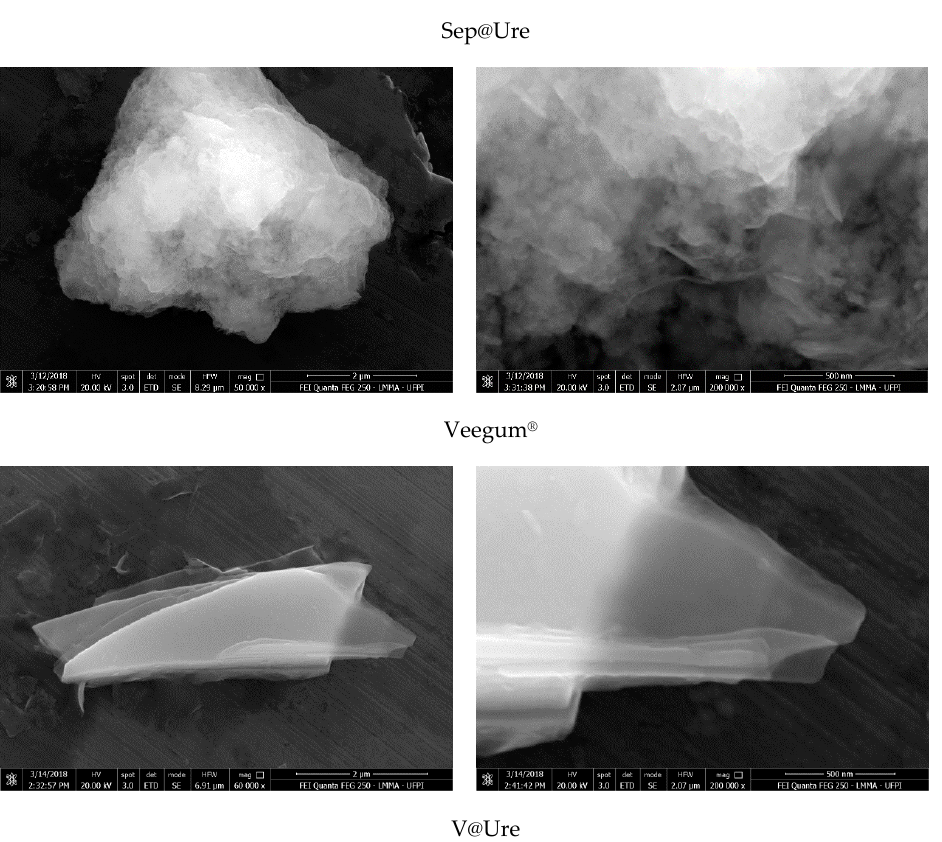
Figure 4. SEM images of the Pal, Sep, and V clay minerals before and after urea